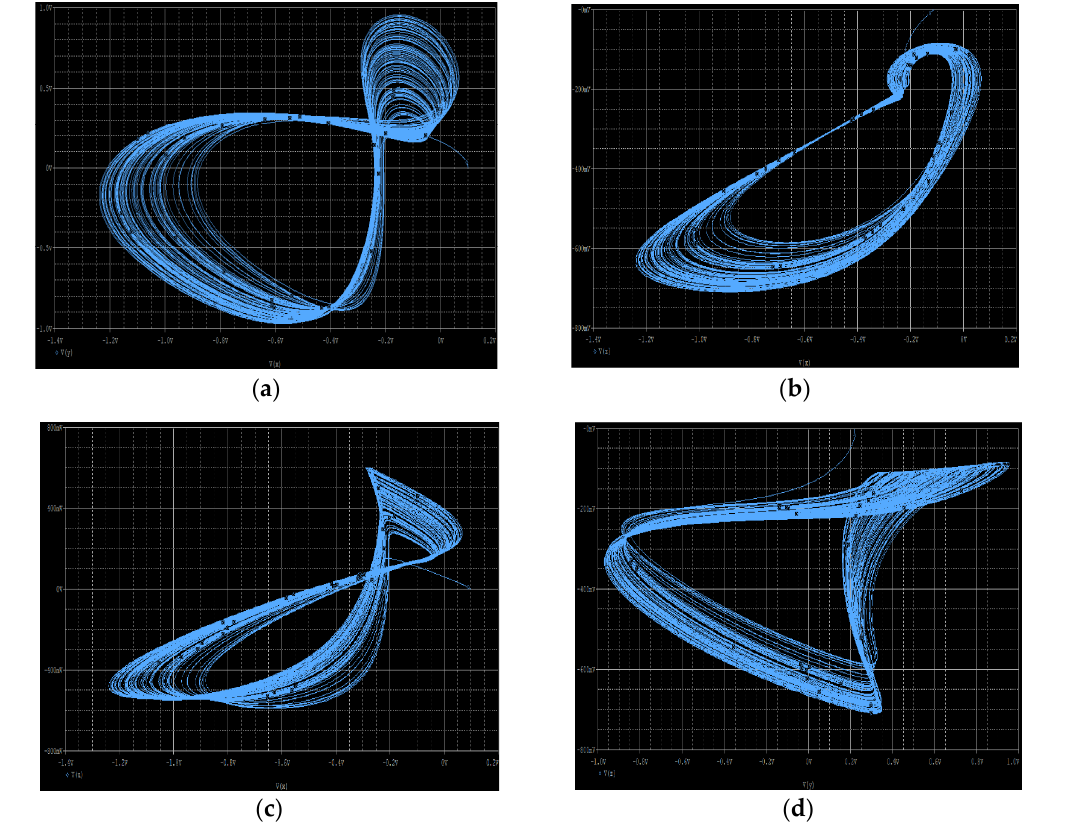
Figure 17. Simulation results of chaotic attractors: ( a ) x ‐ y phase portrait; ( b ) x ‐ z phase portrait; ( c ) x ‐ u phase portrait; ( d ) y ‐ z phase portrait.